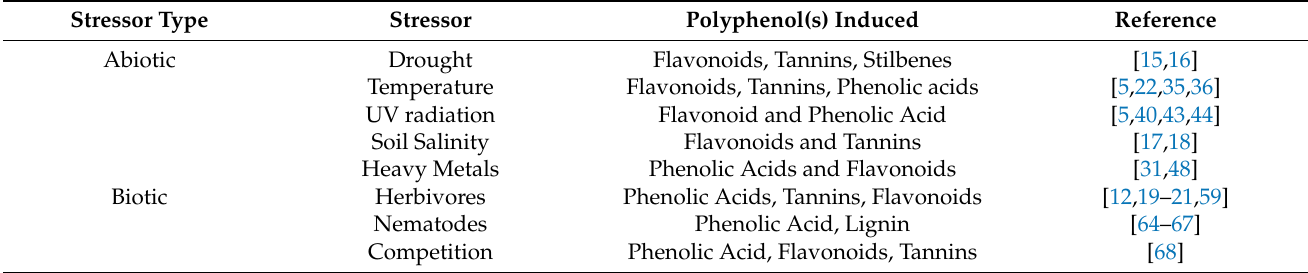
Table 1. Summary of the most common polyphenols synthesized in response to various environmental stressors.